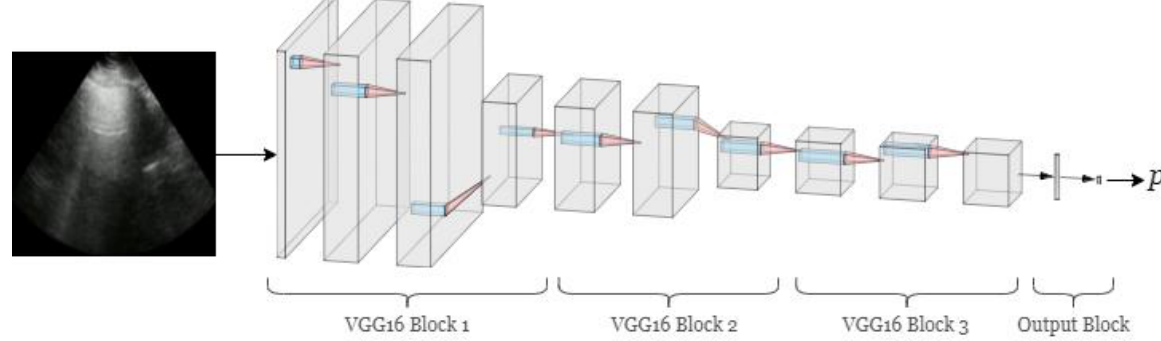
Figure 5. Neural network model architecture. The model consists of the first 3 blocks of VGG16. Each VGG16 block is a